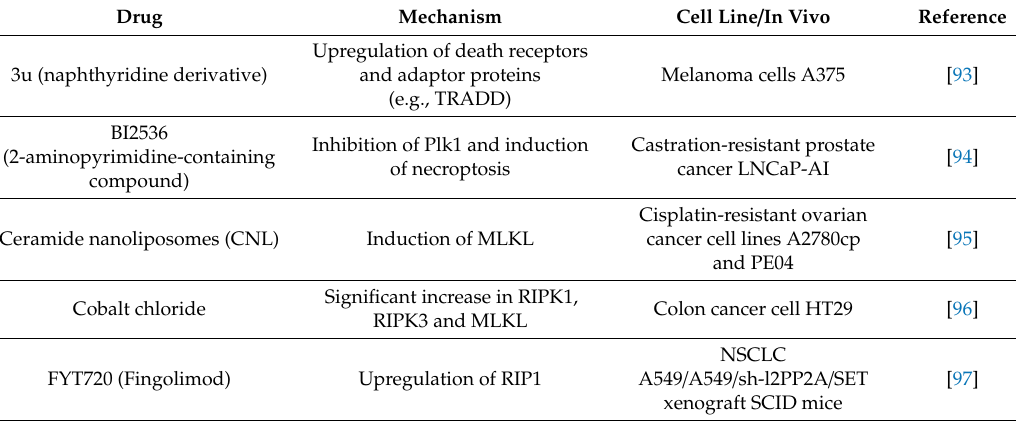
Table 1. Treatments targeting